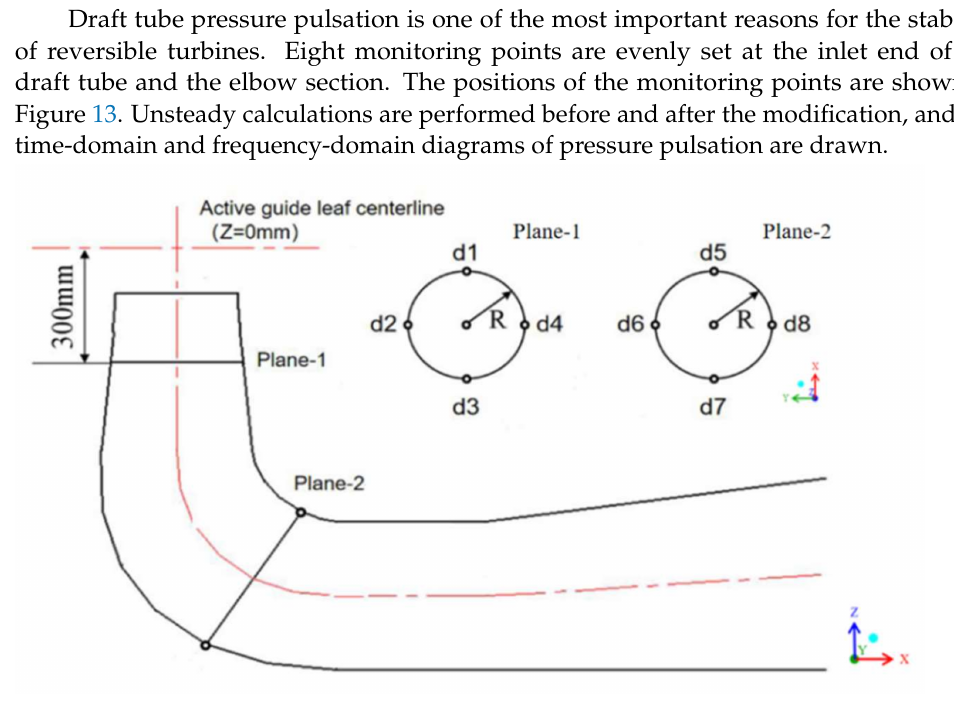
Figure 13. Schematic diagram of pressure pulsation monitoring